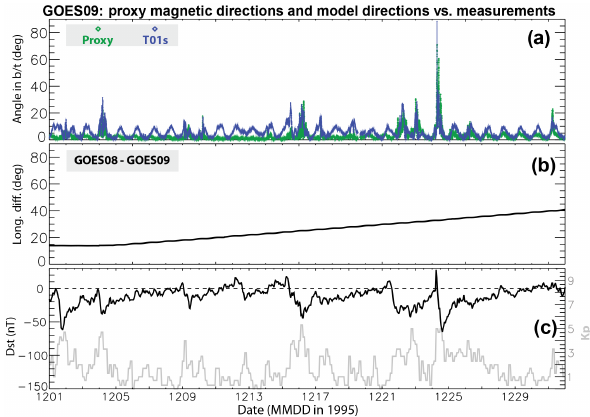
Figure 5. Validating the proxy method of using measurements from a neighboring satellite. (a) In this 1-month period, deviation angles between the proxy magnetic field direction and in situ measure- ments (green) along the GOES-09 orbit are plotted as a function of time, compared to angles between T01s model and measurements (blue). (b) During the period, the relocation of GOES-09 makes its longitude separation with GOES-8 varying from ∼ 15 ◦ to up to 40 ◦ . (c) Dst (black) and Kp (gray) indices. Minor and moderate magnetic activity is observed during the